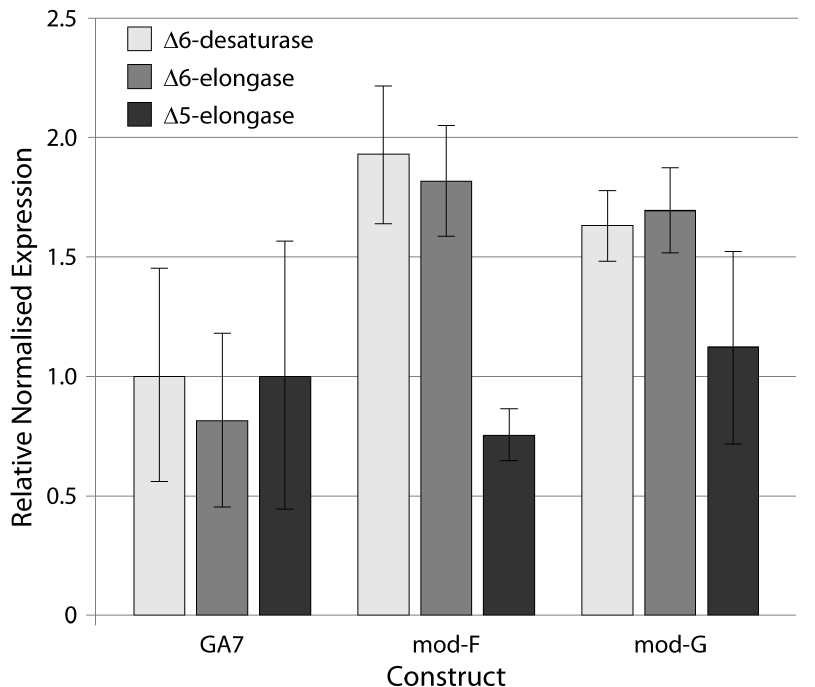
Figure 4. Average relative expression levels of the transgenic D 6-desaturase, D 6-elongase and D 5-elongase from three biological replicates of transgenic C.sativa events transformed with constructs GA7, mod-F or mod-G. Error bars represent standard error. The data shown is for the D 6-desaturase # 1 for the mod-F construct (Figure 2) with the # 2 desaturase found to have expression levels similar to the # 1 gene across multiple events.